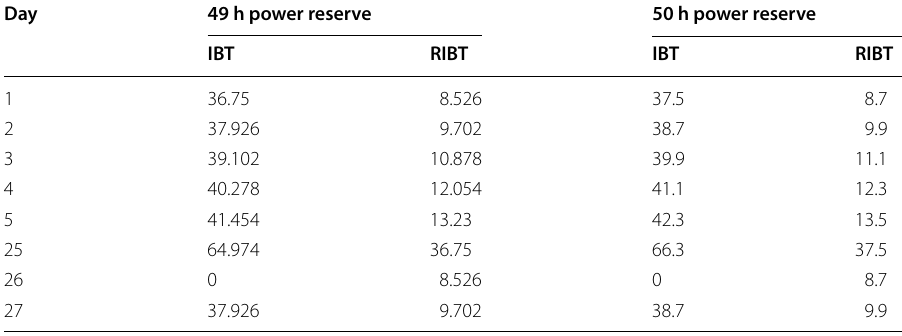
Table 4 In beat time and remaining in beat time for power reserves 49 and 50 Day 49 h power reserve 50 h power